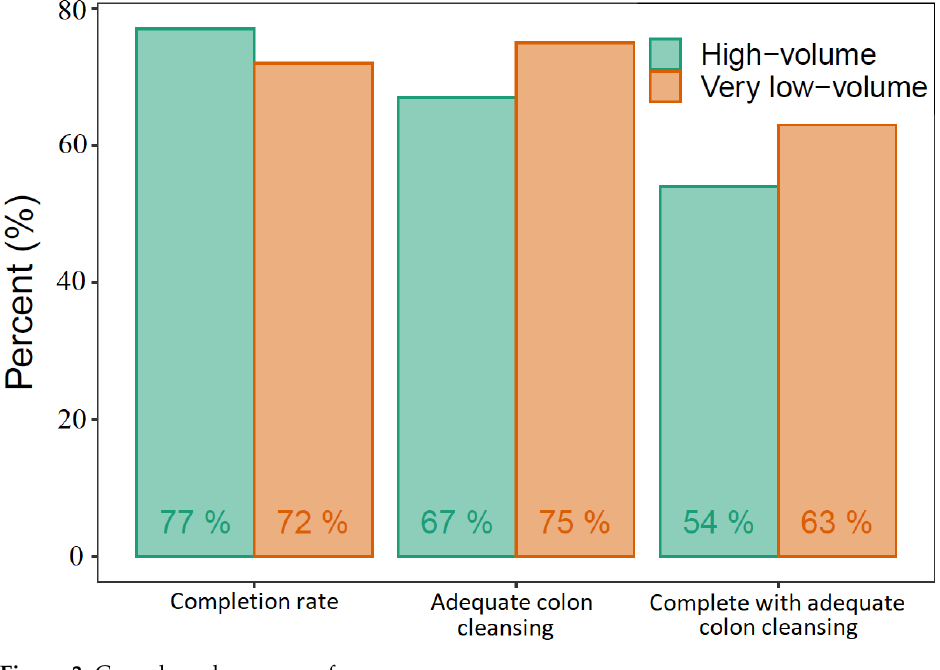
Figure 3. Capsule endoscopy performance. Table 3. Capsule endoscopy performance.